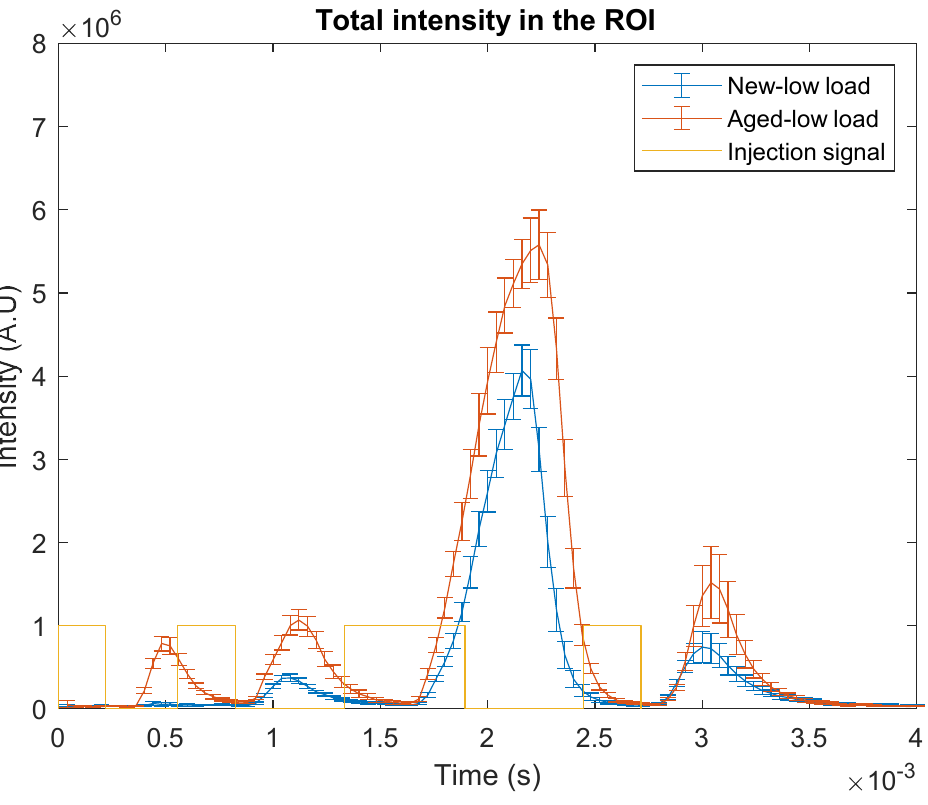
Figure 6. Mie-scattering signal at medium load using different injectors.